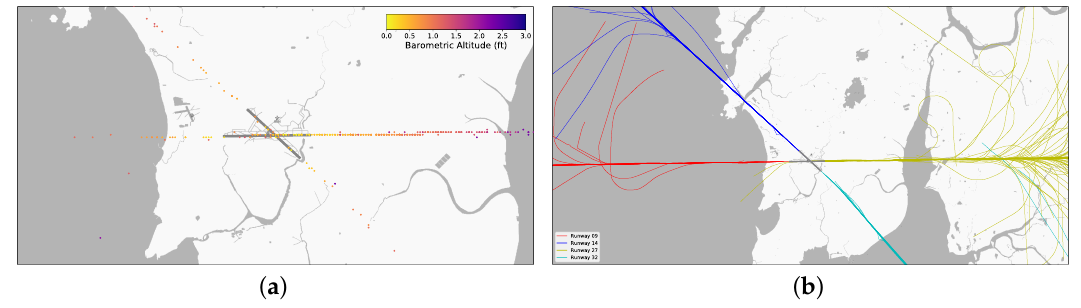
Figure 3. Locations of go-arounds at VABB. ( a ) Go-around locations marked by a single point, colour-coded by barometric altitude at the time of the go-around. ( b ) Trajectories for each aircraft that went around over the prior five